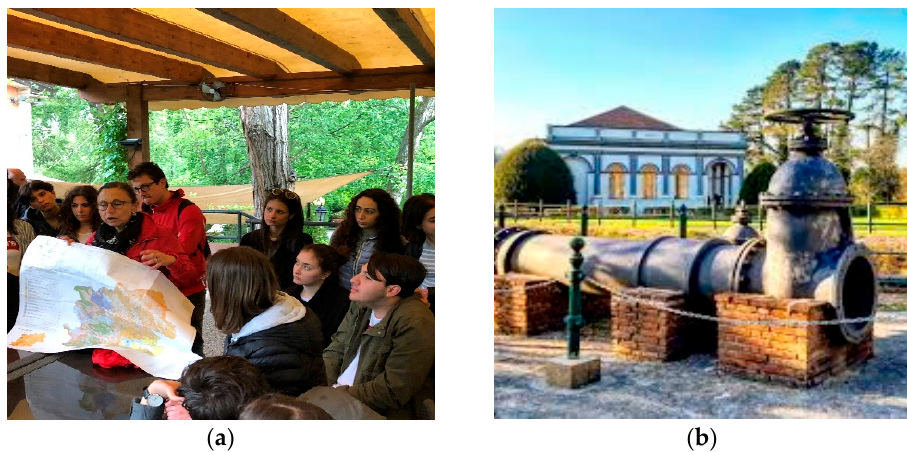
Figure 4. Knowledge of the hydrogeological behavior of karst springs: ( a ) visit to the karst area of the Grassano springs (San Salvatore Telesino, Benevento Province) (year 2017); ( b ) the upwelling groundwater flow in the Serino area (Serino, Avellino Province) (year